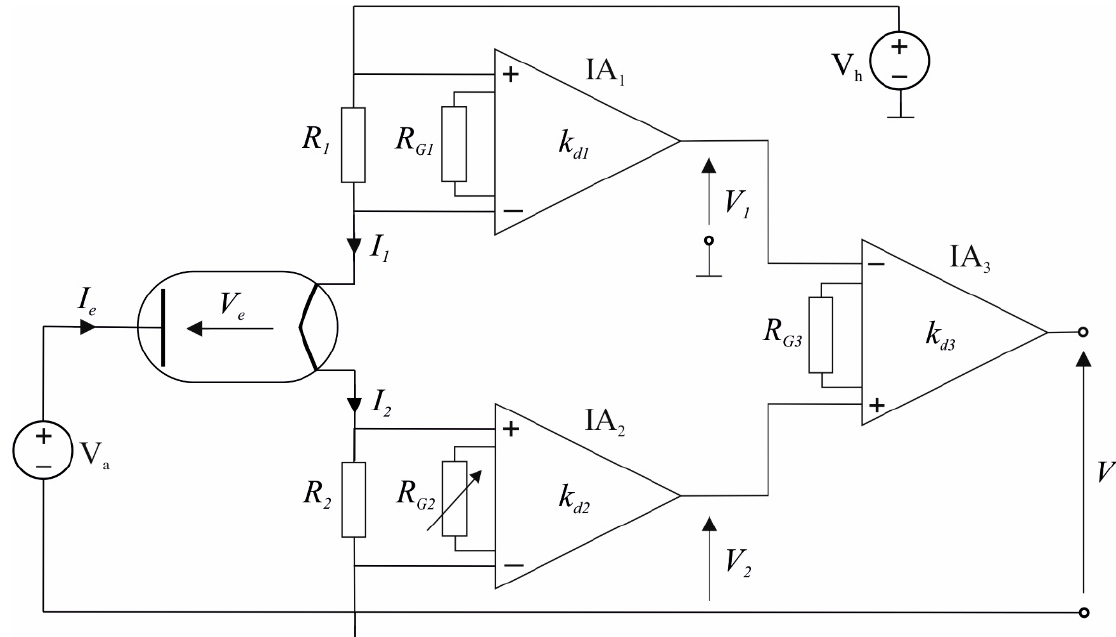
Figure 8. A simplified scheme of the I e - V cathode converter. IA 1 , IA 2 , IA 3 are instrumentation amplifiers AD8221 (Analog Devices), R 1 , R 2 are sensing resistors (Caddock Electronics), R G 1 = 49.42 k Ω ; 47 k Ω ≤ R G 2 ≤ 52.47 k Ω V h is the LPS-305 power supply (Motech Industries INC.), V a is the CPX400DP (Aim TTi) power supply, all instrumentation amplifiers are powered with +/ − 15 V from the DF 1743005C (NDN) power supply.